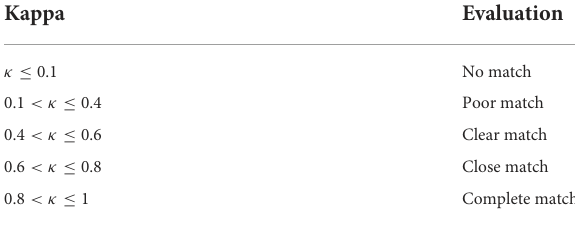
TABLE 2 Evaluation of the Cohen’s Kappa value from Landis and Koch